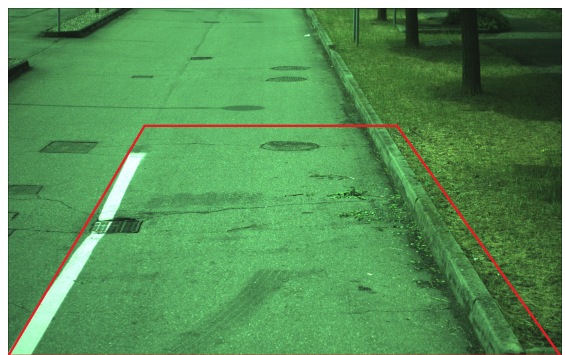
Figure 3. The original picture as taken by the camera (1920 × 1200 in our experiments), with highlighted the zone analyzed by algorithm.